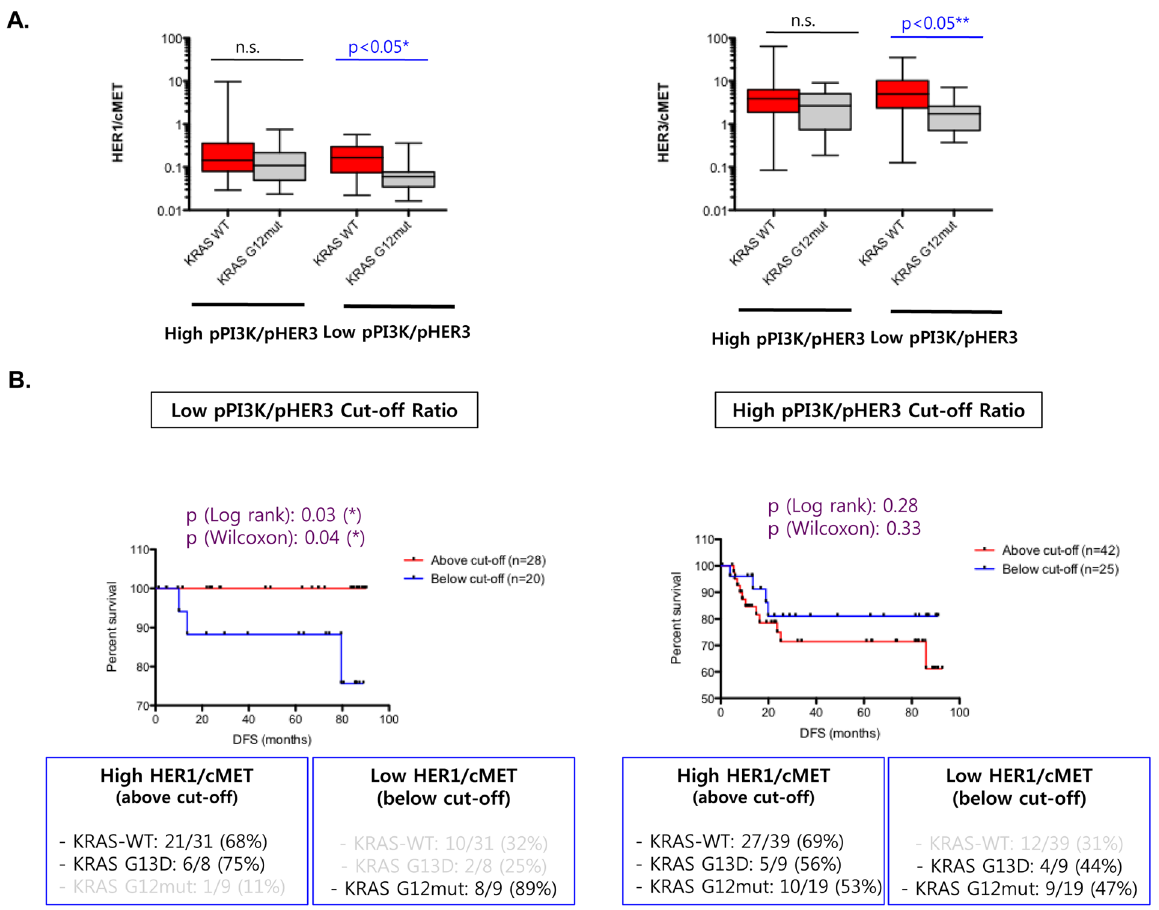
Figure 3. Relative c-MET and IGF1R expression in high and low PI3K signaling colorectal cancer (CRC) cohorts. (A) pMET/T-c-MET ratio was compared between high PI3K (high pPI3K/pHER3) and low PI3K (high pPI3K/pHER3) groups using the Mann–Whitney t -test. The comparison is shown in all CRCs, KRAS WT, G13D mutated, and G12 mutated CRCs. Significant differences with p-values are indicated in blue. (B) Comparative expression between high and low PI3K groups for the following markers: pHER1/pMET, pHER2/pMET, pHER3/pMET, pHER1/pIGF1R, pHER2/pIGF1R, and pHER3/pIGF1R. Significant differences with p-values are indicated in blue.